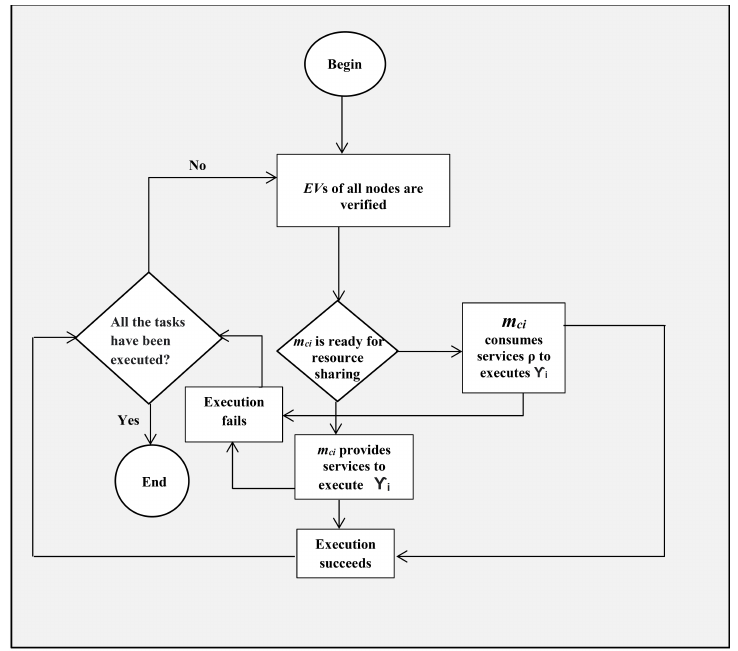
Figure 7. Procedural flowchart for resource sharing.